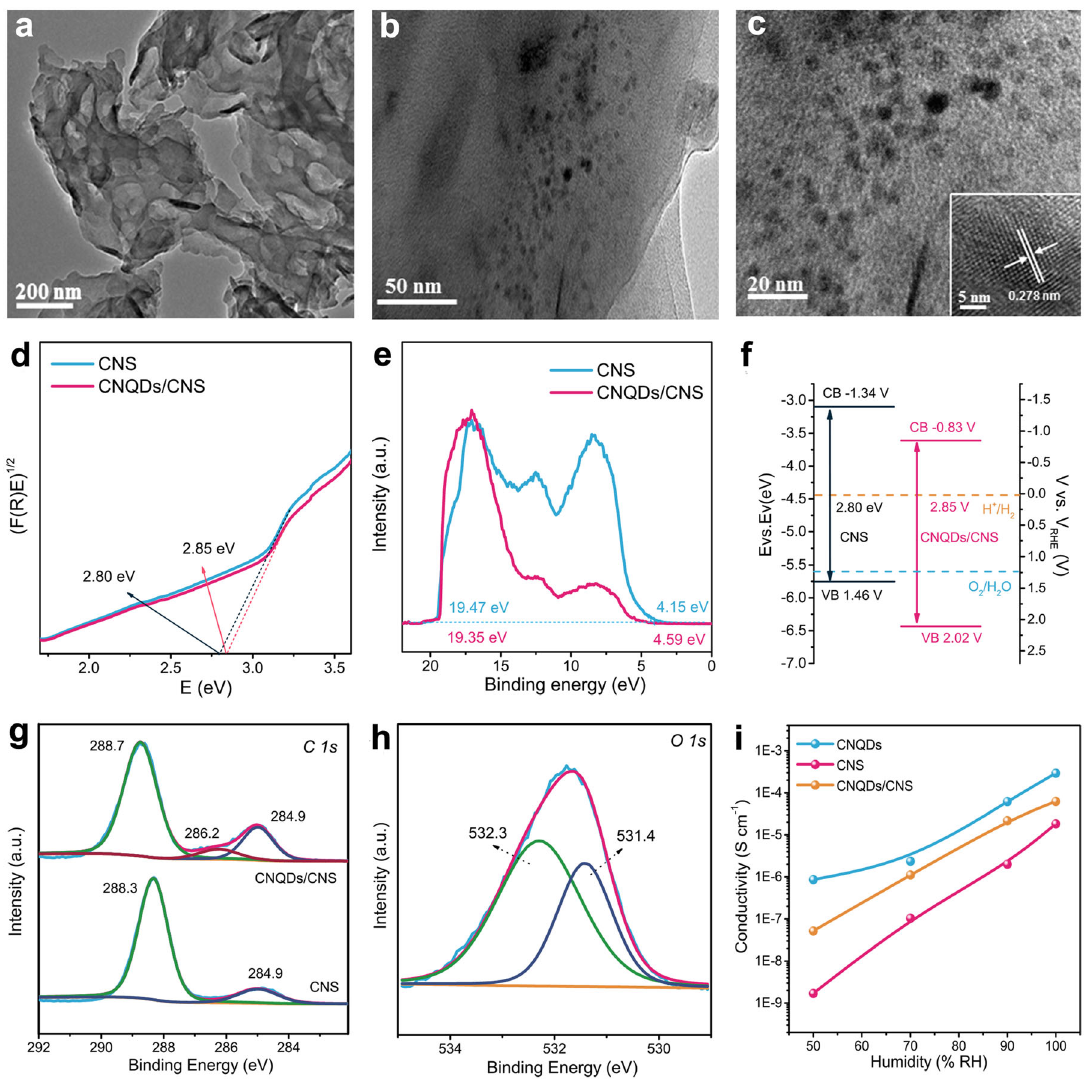
Fig. 1 Structure, bandgap states, and proton conductivity of CNS and CNQDs/CNS. a TEM image of as prepared CNS by chemically exfoliating graphitic carbon nitride. b TEM image of the CNQDs/CNS laminate structure. c HRTEM image of the CNQDs/CNS. Inset: the individual CNQDs embedded on the CNS. d Band gap measured by UV – vis diffuse re fl ectance spectroscopy (DRS). e UPS spectra vs. vacuum by subtracting the width of the He I UPS spectra from the excitation energy (21.22 eV). f The band structure diagram of the CNS and CNQDs/CNS. g High-resolution XPS spectra of C 1 s of the CNS and CNQDs/CNS for C 1 s energy level, h the O 1 s spectra of the CNQDs/CNS. i Proton conductivities ( σ ) of the CNQDs, CNS, and CNQDs/CNS with respect to RH at 298